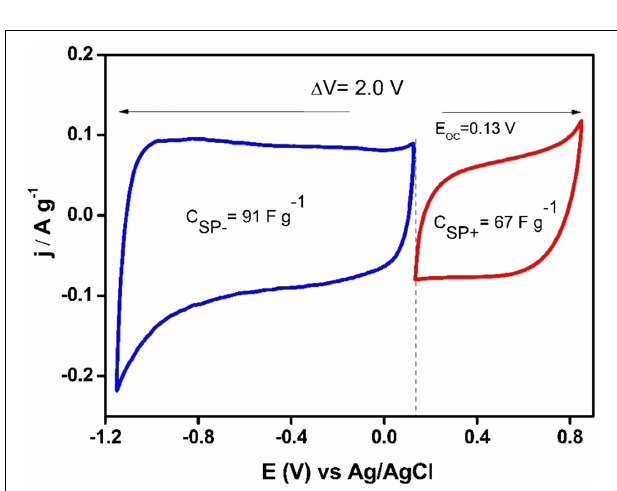
FIGURE 9 | Steady voltammograms to design an asymmetric supercapacitor based on ACM sample ( υυυ = 1mVs (cid:0) 1 ; 0.5M Na 2 SO 4 ) .